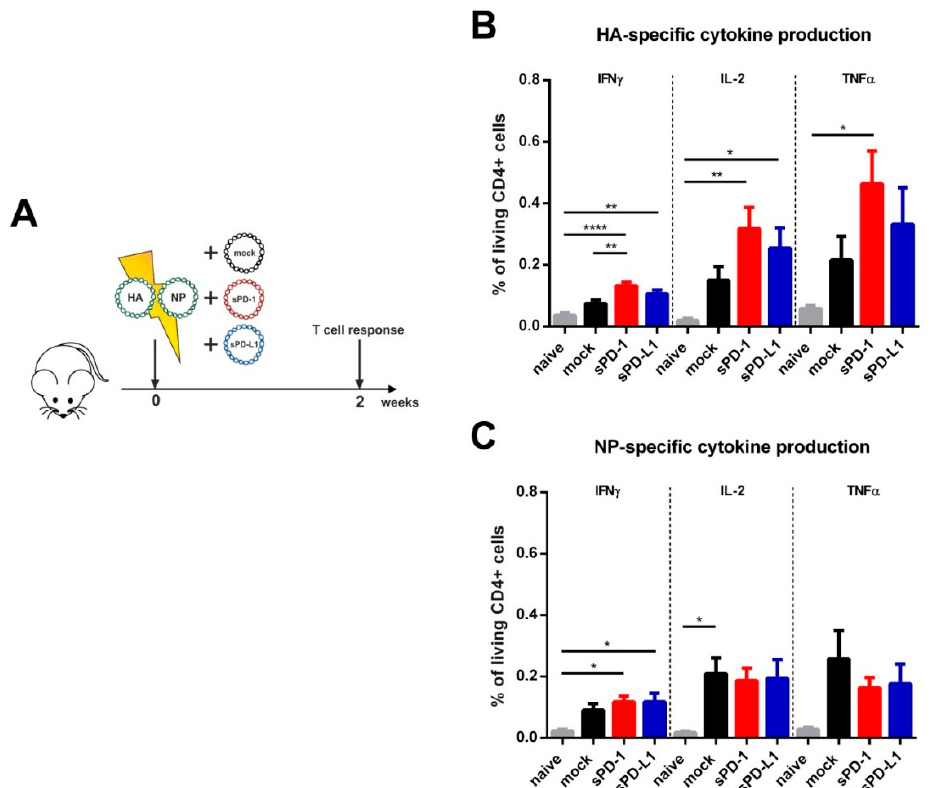
Figure 2. Immunization outline and HA- and NP-specific CD4 T cell responses. ( A ) Six-week old BALB/c mice were electroporated intramuscularly with expression plasmids encoding for HA and NP. Additionally, the animals were either co-electroporated with an empty vector (mock) or plasmids encoding for the soluble ectodomains of PD-1 (sPD-1) or PD-L1 (sPD-L1). After two weeks, mice were sacrificed, and T cell responses analyzed. Percentage of CD4 + T cells producing IFN γ , IL-2 or TNF α after in vitro stimulation with influenza HA ( B ) and NP ( C ) T helper peptides (measured by intracellular cytokine staining). Shown are mean values with SEM ( n = 5–9) and significant differences between the groups (one-way ANOVA analyses followed by Tukey’s multiple comparison test, * p < 0.05 , ** p < 0.01 , **** p < 0.0001 ).